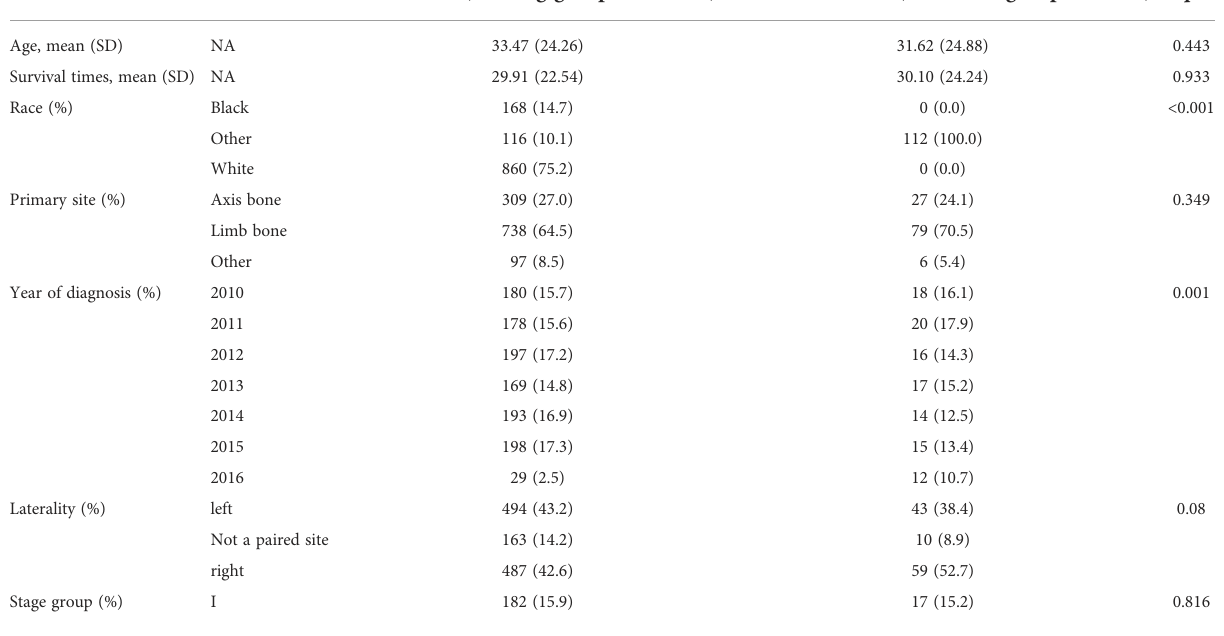
TABLE 1 Baseline data table of the training group and the validation group.